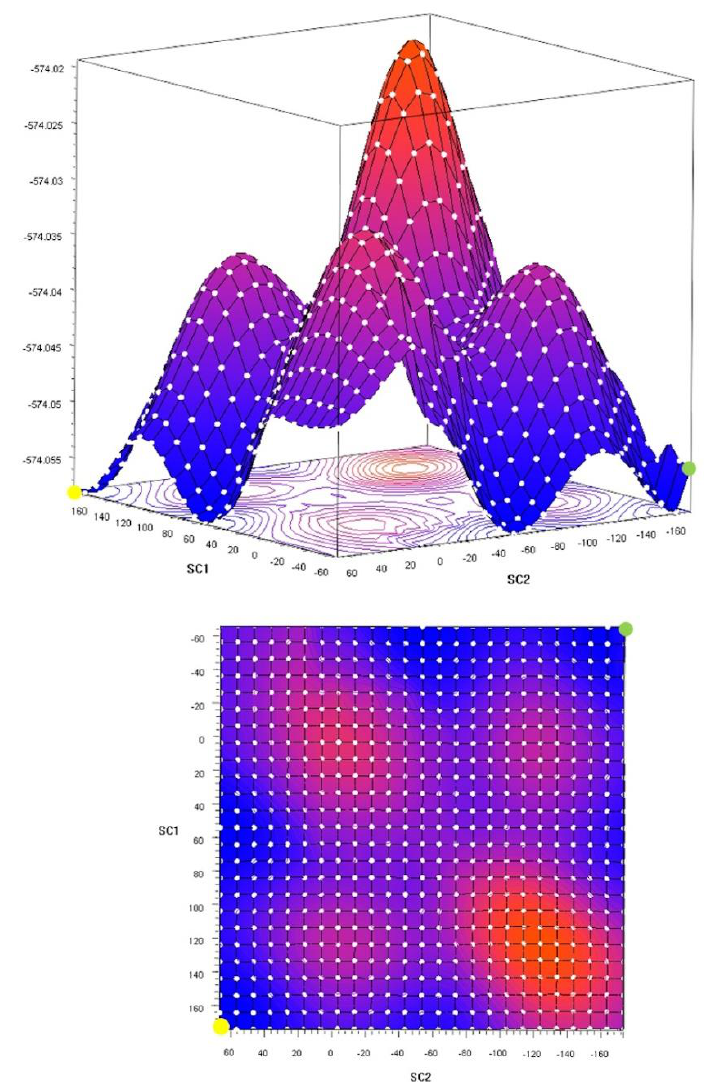
Figure 9. Gaussian Scan Grids (2D and 3D). Energies are equal to − 574.058 Hartree and − 564.054 Hartree for the rotamers 1 and 2 , respectively. The difference between them was equal to 10.5 kJ/mol. Rotamers 1 (rotation around the C2–C3 bond) and 2 (rotation around the C3–C4 bond) were marked by yellow and green points,